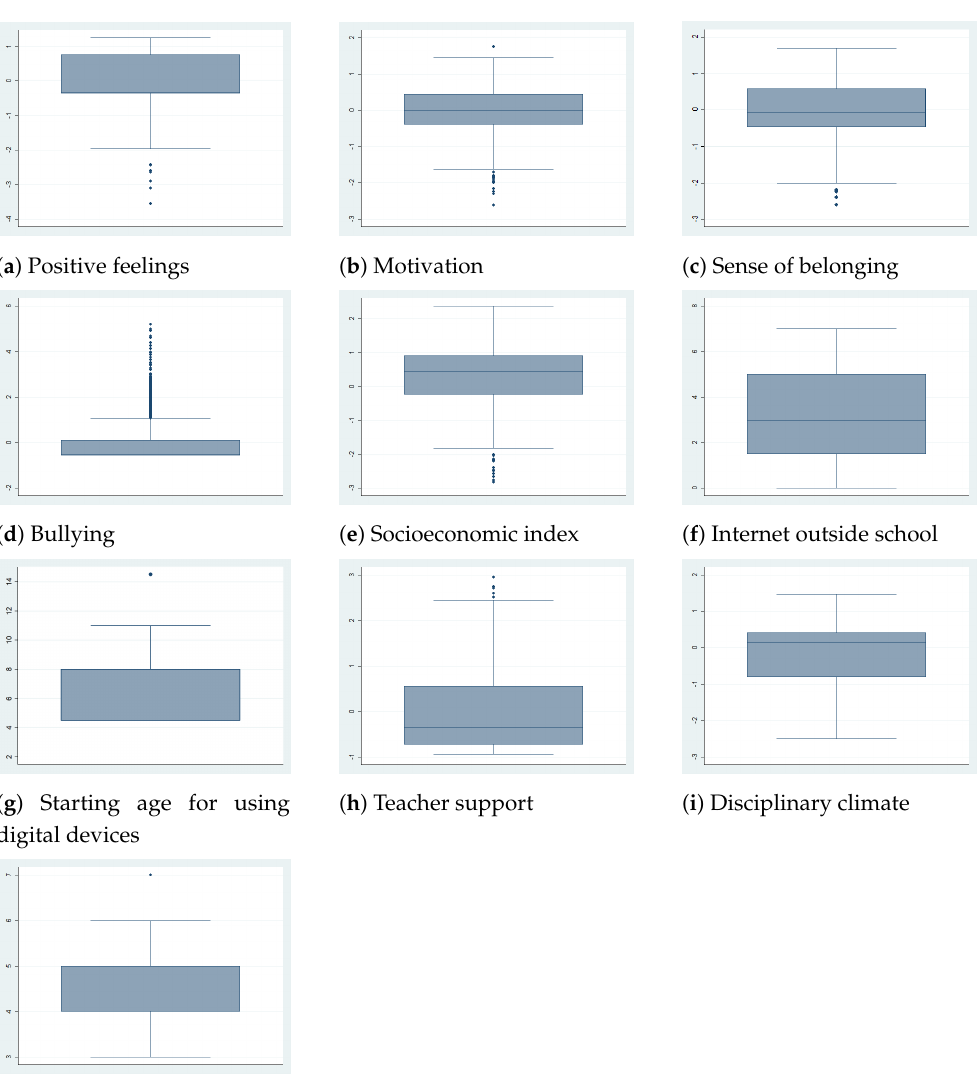
Figure 2. Box-plots of the variables for the Finnish